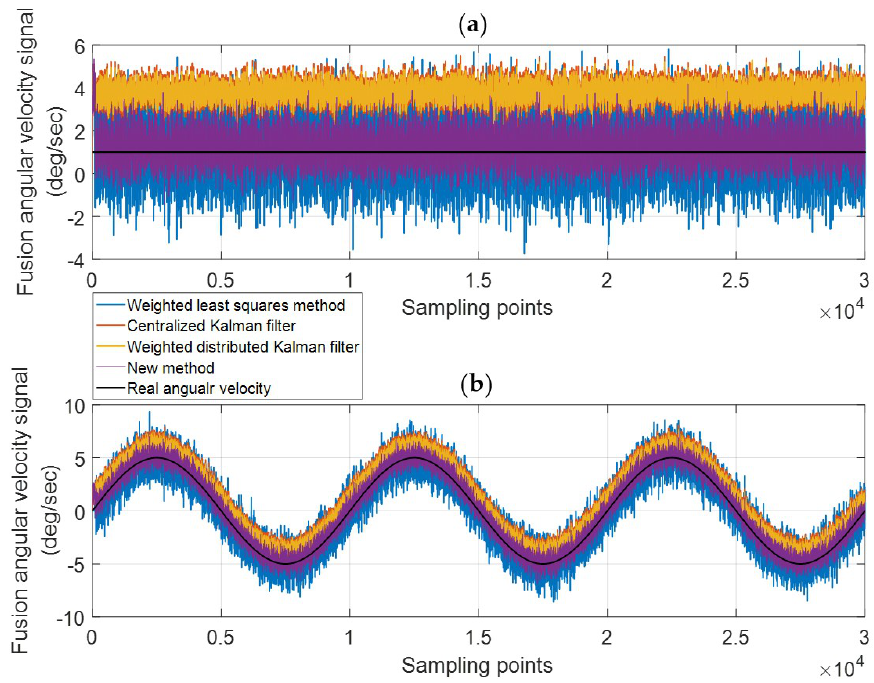
Figure 13. The fusion results for the constant drift case. ( a ) X Axis; ( b ) Z Axis.